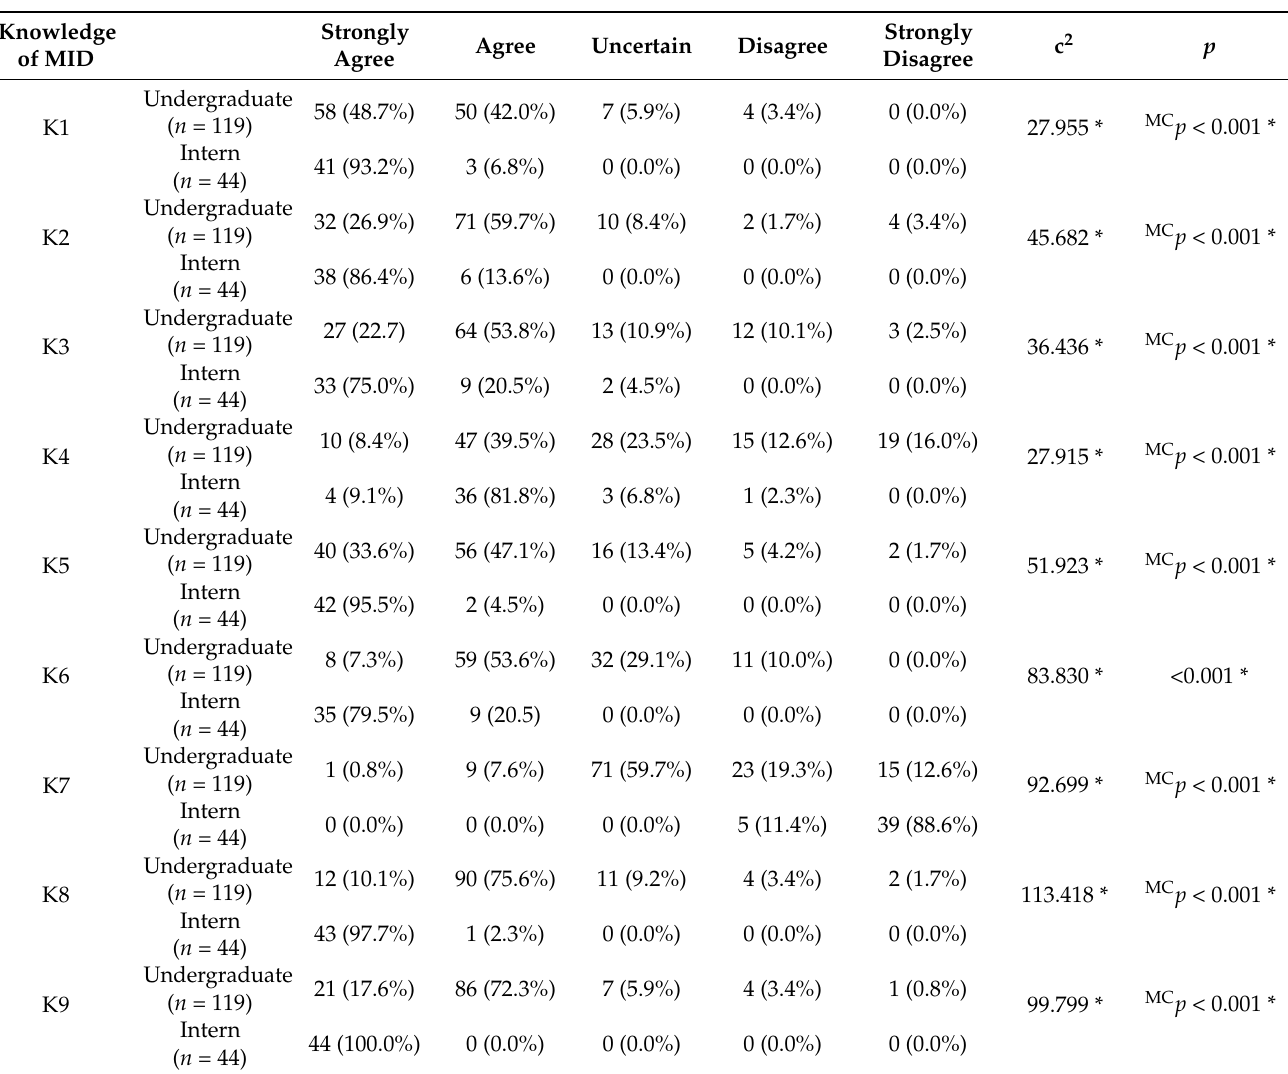
Table 4. Comparison between undergraduate students and interns according to their responses to knowledge (K) of MID.